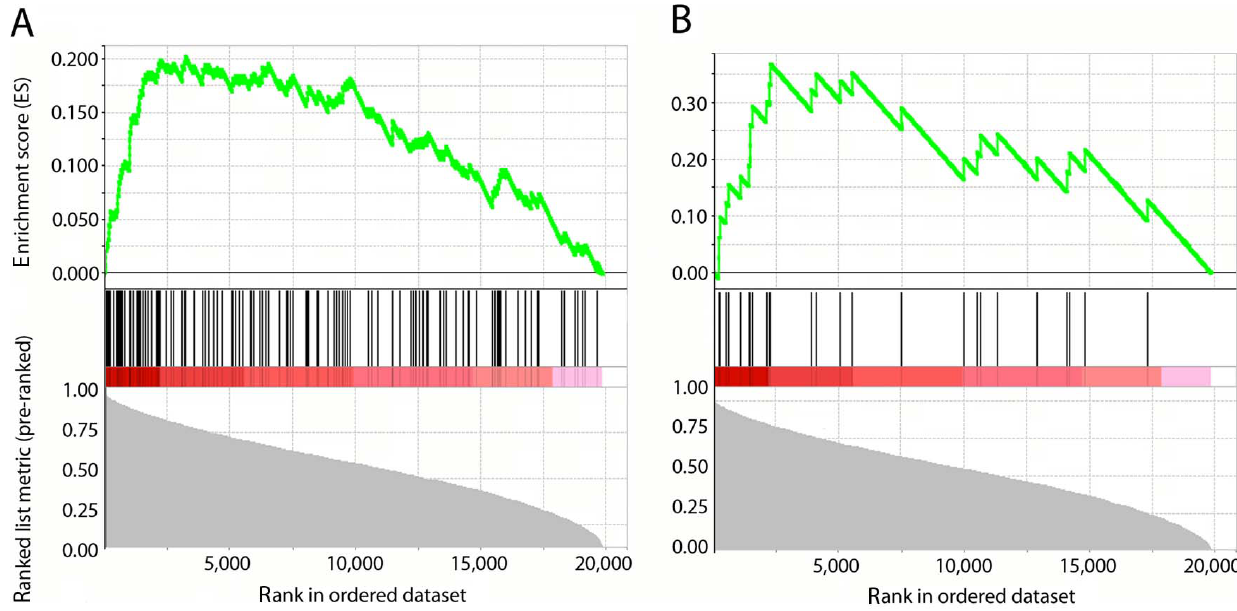
Figure 7. Significant enrichment of DRBP76-associated mRNAs from HEK 293 cells and histone mRNAs in brain tumor derived HTB- 14 cells. Transcripts rank-ordered by average percentile rank representing differential enrichment in DRBP76 IP from HTB-14 cells. A . Black lines indicate the rank of each individual DRBP76-associated mRNA identified from HEK293 cells (p , 0.001). B . Black lines indicate the rank of each individual histone mRNA detected (p , 0.001).